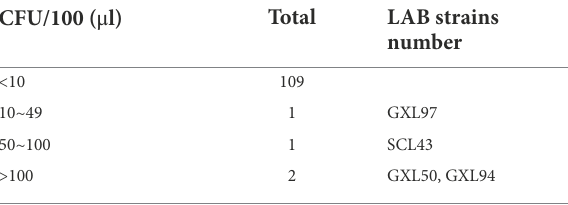
TABLE 1 Resistance of LAB strains to hydrogen peroxide.